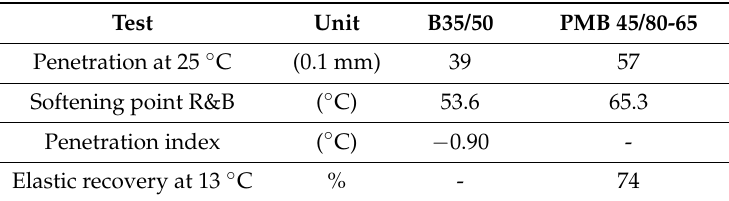
Figure 2. Aggregate gradation for stage 2. Table 3. Properties of the evaluated asphalt binders.